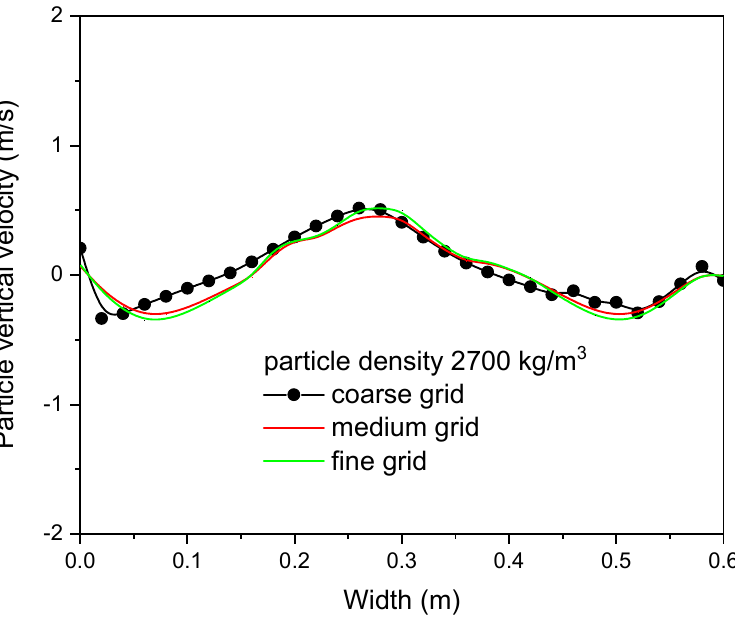
Figure 2. Effect of grid size on the axial-averaged particle velocities (2700 kg/m 3 ).